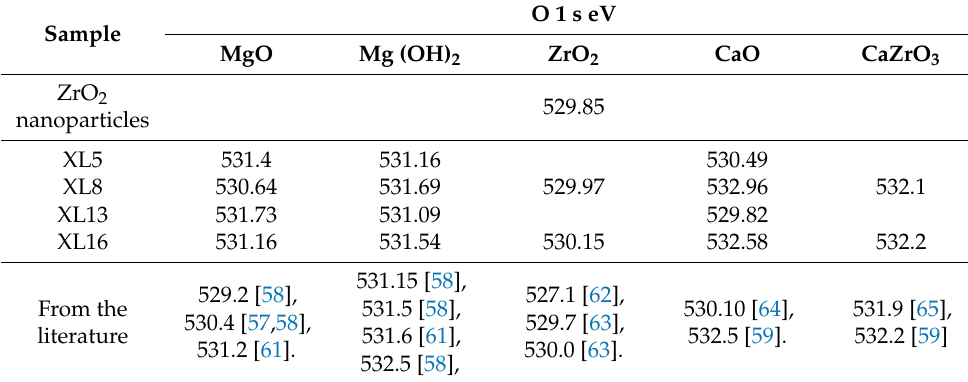
Table 2. Binding energy corresponds to O 1 s eV peaks of MgO, Mg(OH) 2 , ZrO 2 , CaO, and CaZrO 3 phases for samples of 100 wt.% MgO sintered a 1550 ◦ C (XL5) and 1650 ◦ C (XL13), samples of